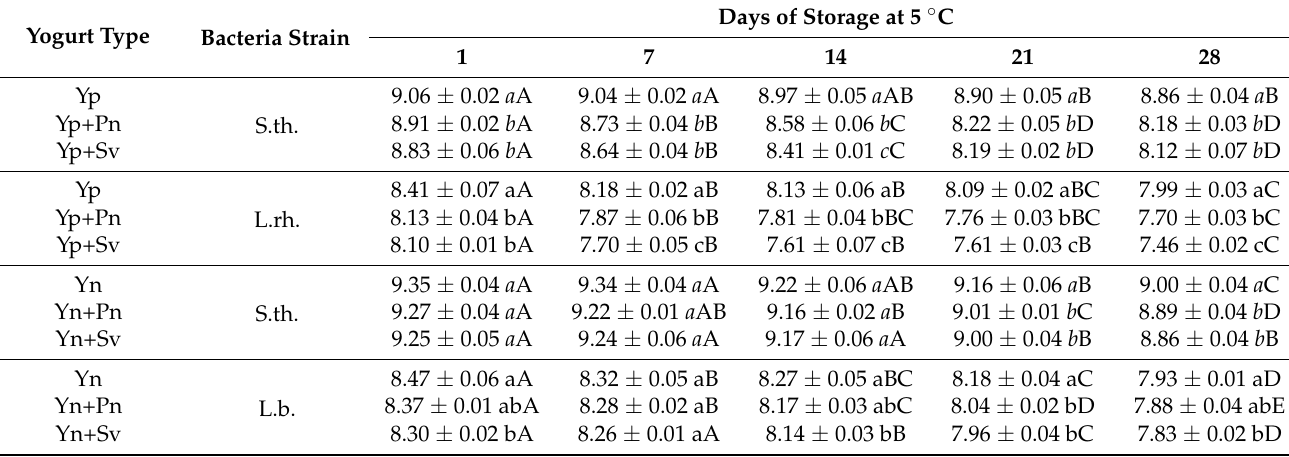
* Mean values of three different determinations followed by standard deviation are presented. a–c , Different letters in a column for S. thermophilus represent statistical differences (ANOVA, Bonferroni test, p < 0.05) ; a–c, Different letters in a column for L. rhamnosus or L. bulgaricus represent statistical differences (ANOVA, Bonferroni test, p < 0.05) ; A–E, Different letters in a row for days of storage represent statistical differences (ANOVA, Bonferroni test, p <